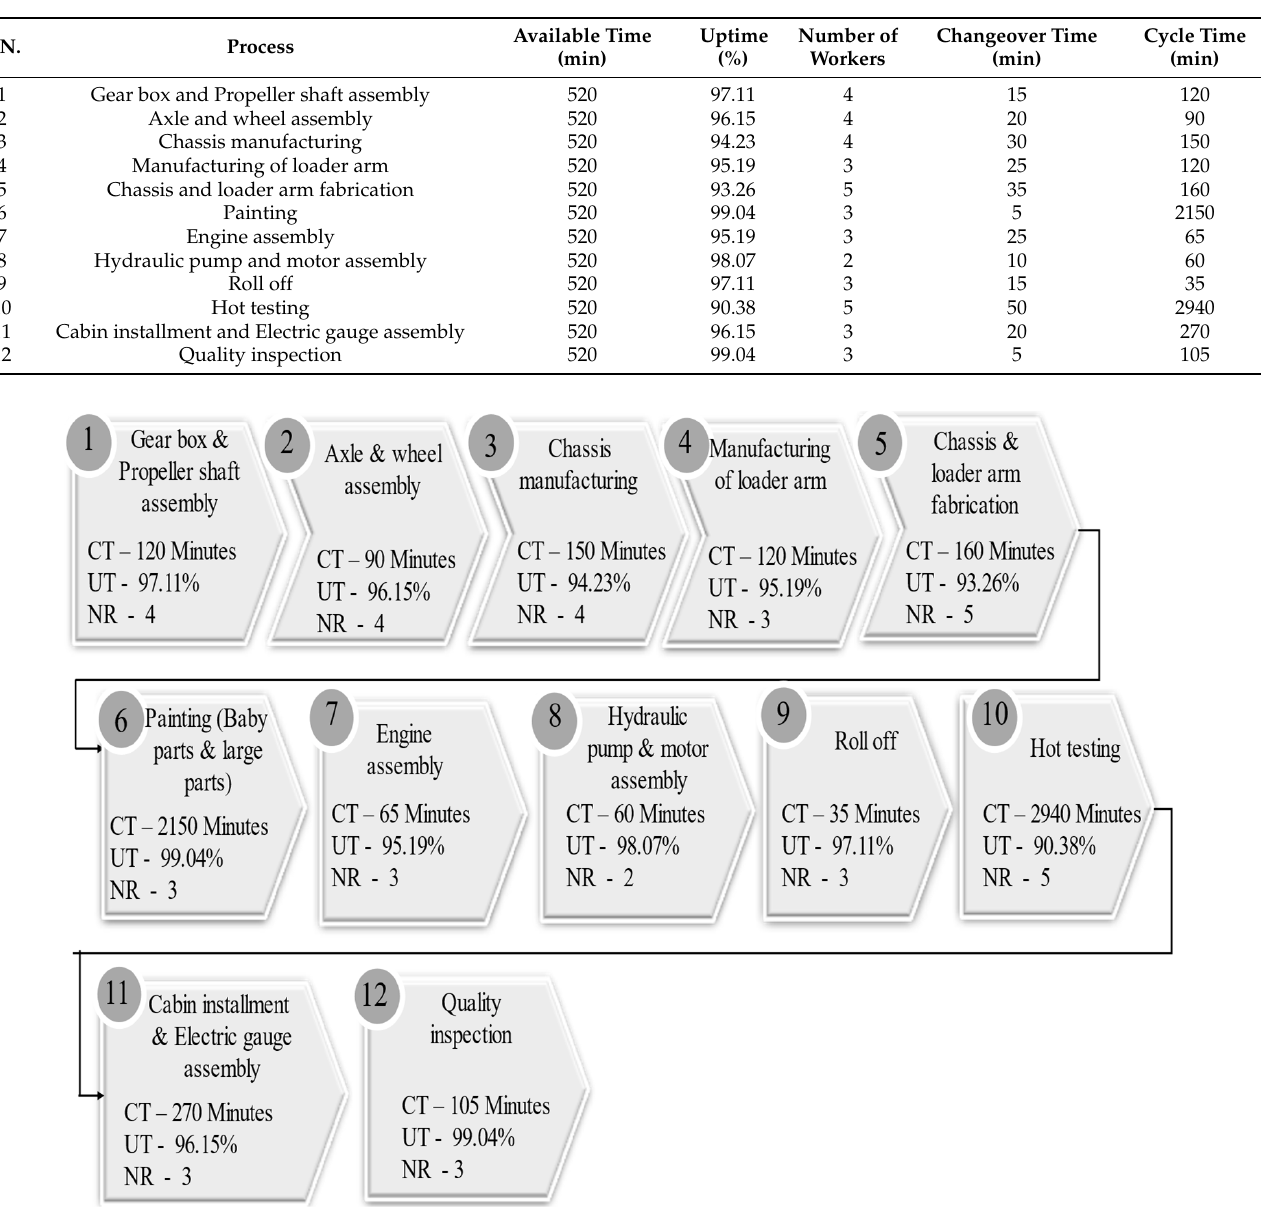
Figure 11. Modified workflow for the proposed shop floor.